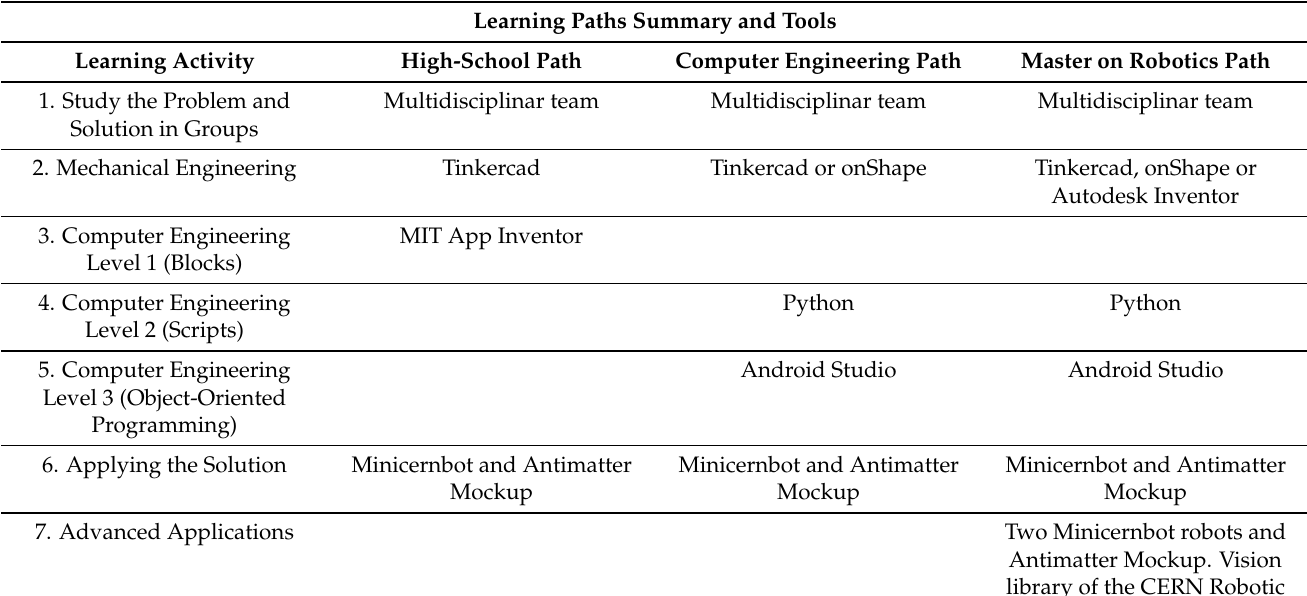
Table 1. Relation between learning paths and experimented